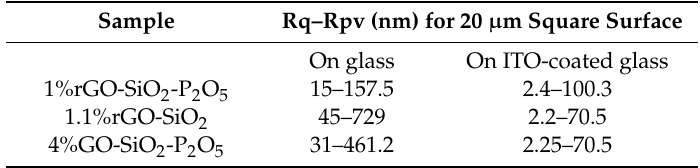
Table 3. The root-mean-squared roughness (Rq) and peak-to-valley (Rpv) from atomic force microscopy (AFM) investigations.